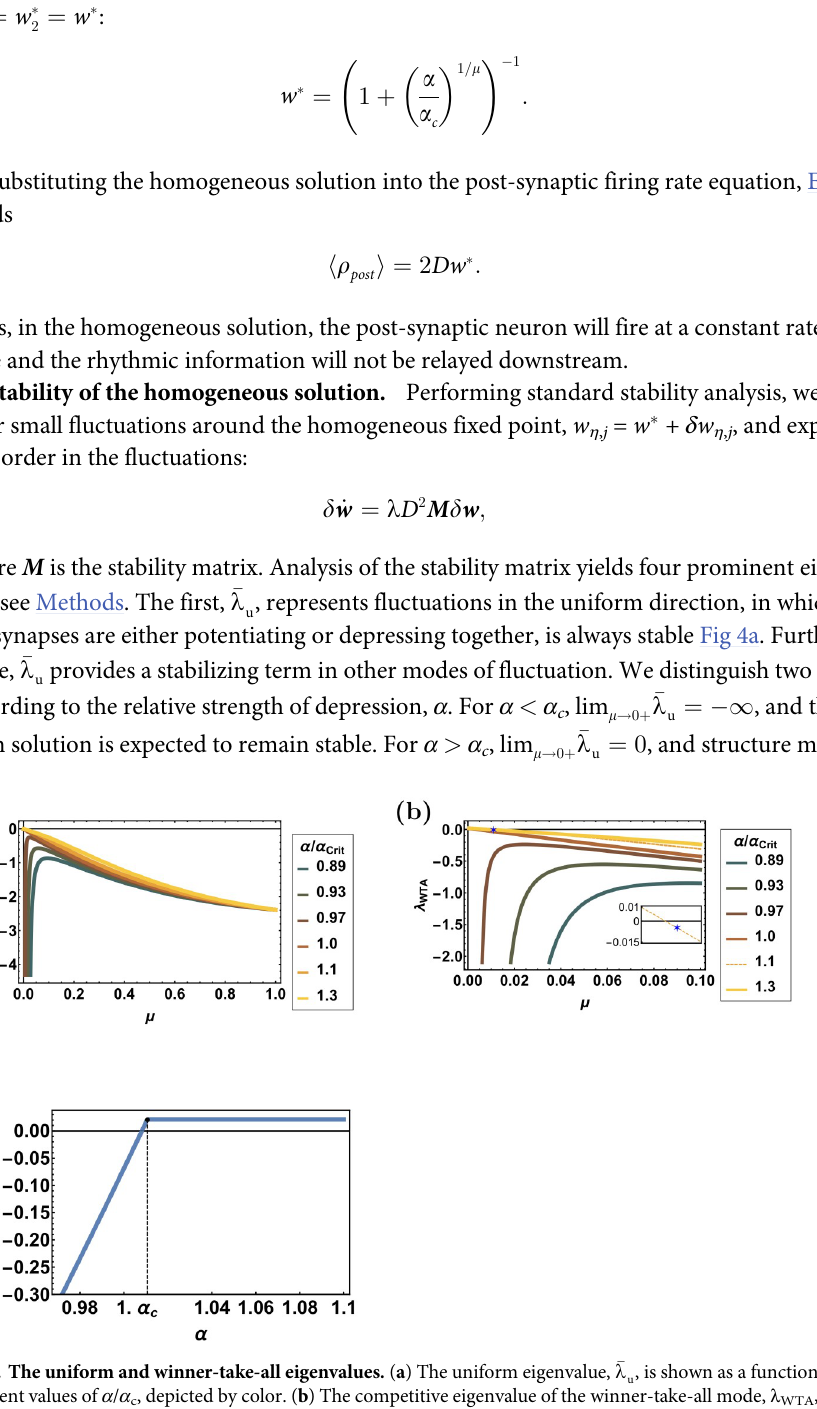
, is shown as a function of μ , for u is obtained on the boundary μ WTA